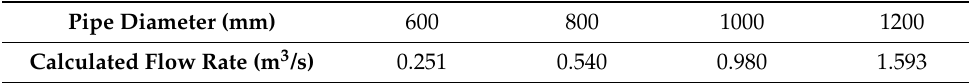
Table 3. Calculated flow rate of different pipe diameter.